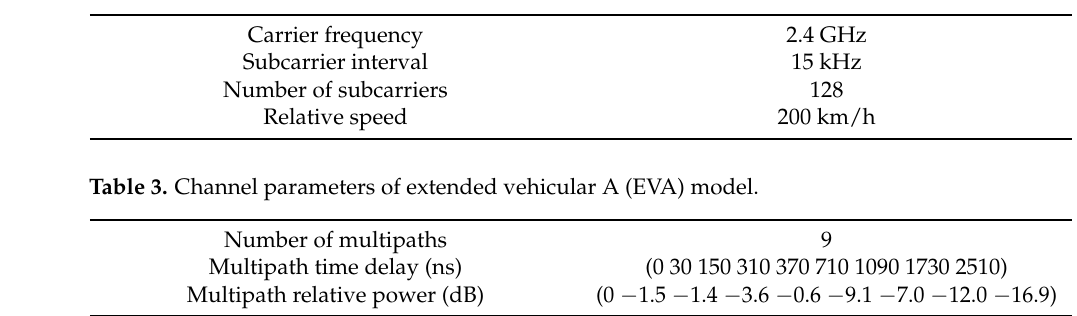
Table 2. System parameters.